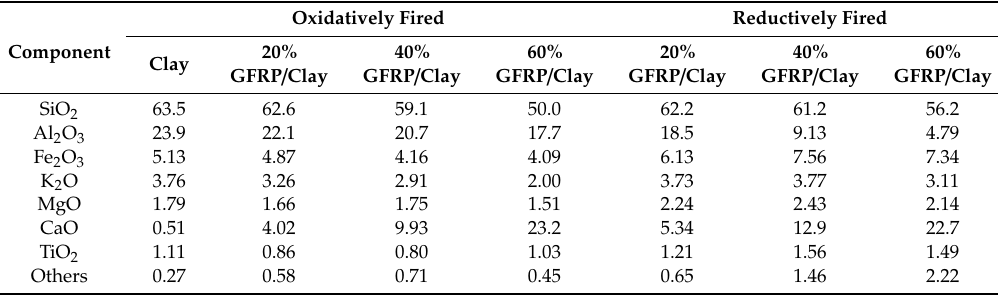
Table 3. The inorganic chemical compositions of the ceramic specimens.